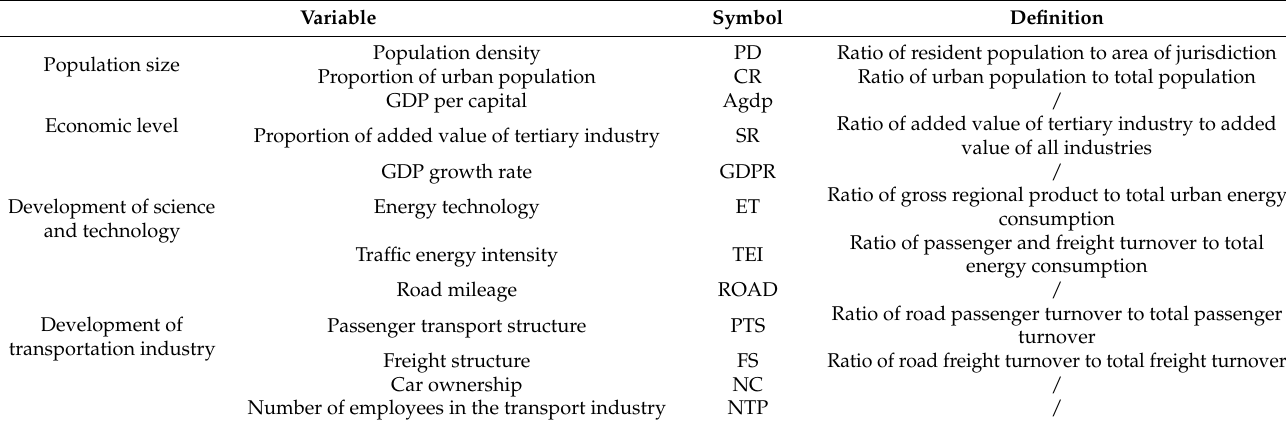
Table 2. Transportation carbon emission impact factor index